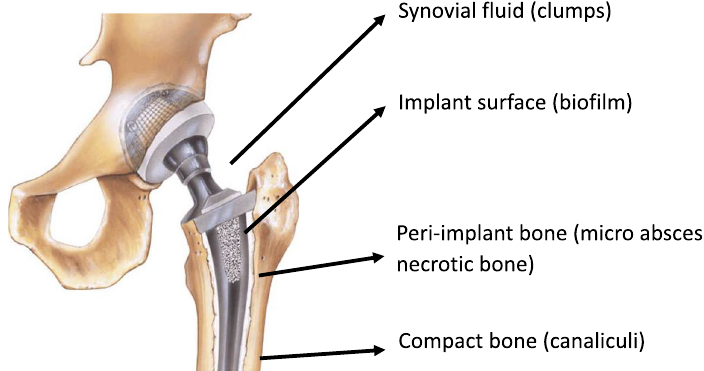
Fig. 1 Potential structures that serve S. aureus small colony variants to protect themselves from immune system and antibiotics (see text for